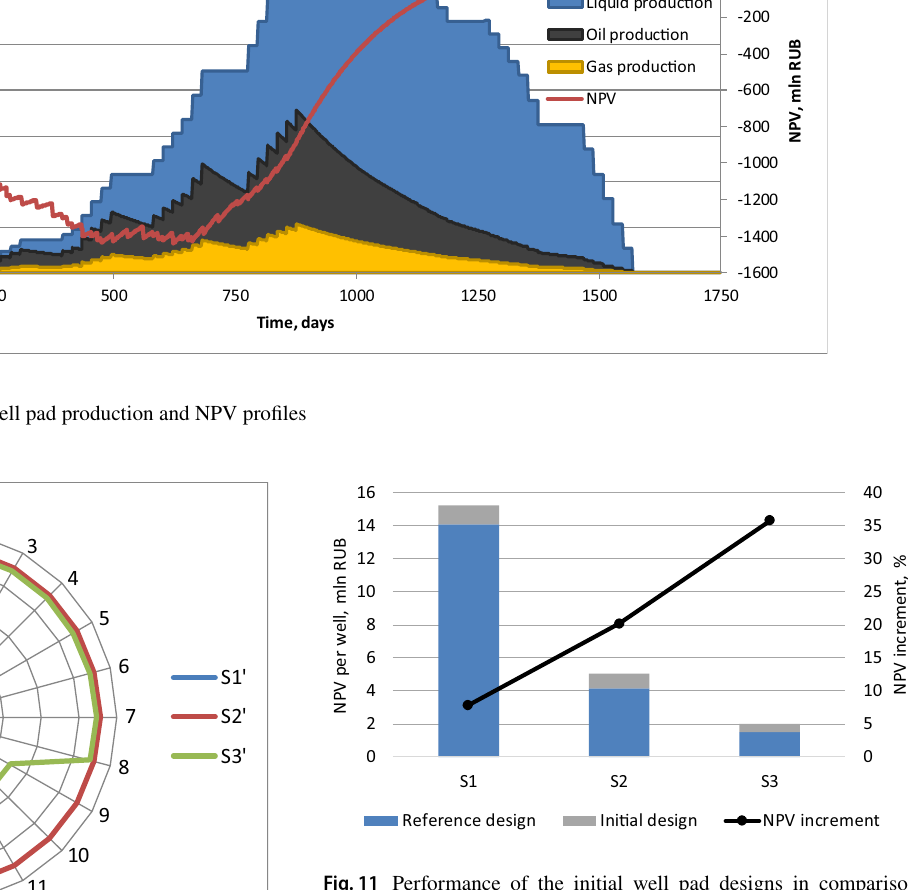
Fig. 11 Performance of the initial well pad designs in comparison with the reference designs for S1, S2 and S3 Table 3 The initial (found for S1, S2 and S3) and corrected well pad designs for scenarios S1 ′ , S2 ′ and S3 ′ (well pad configurations are shown in curly brackets, and a number of wells in every cluster are separated by